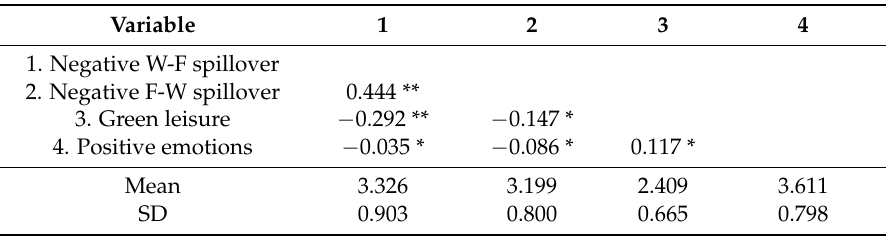
Table 2. Correlation coefficients of the study variables.